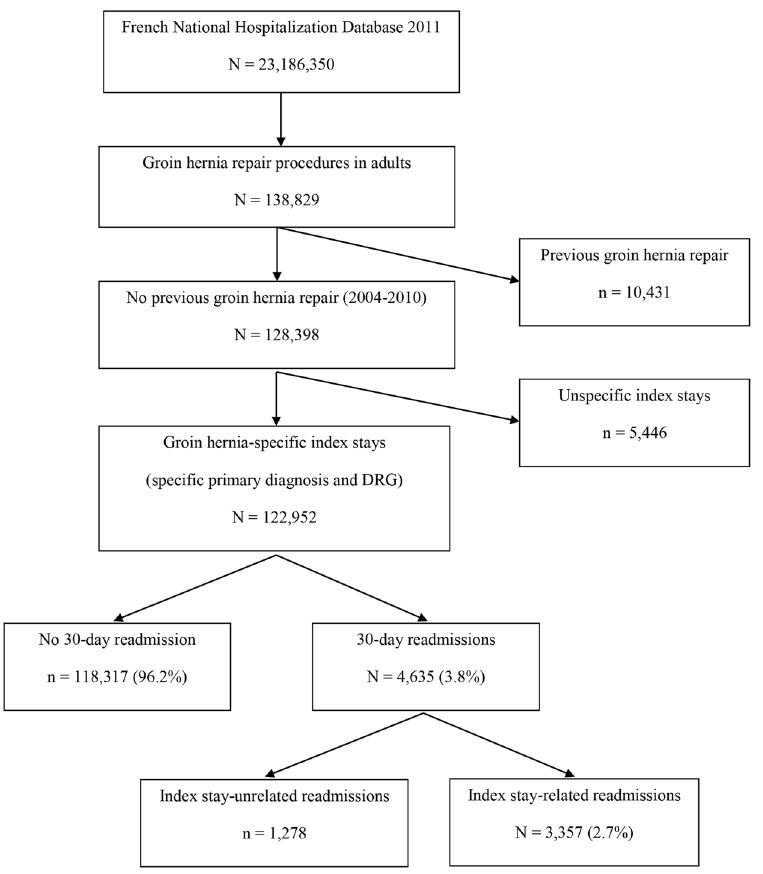
Figure 1. Admissions flow